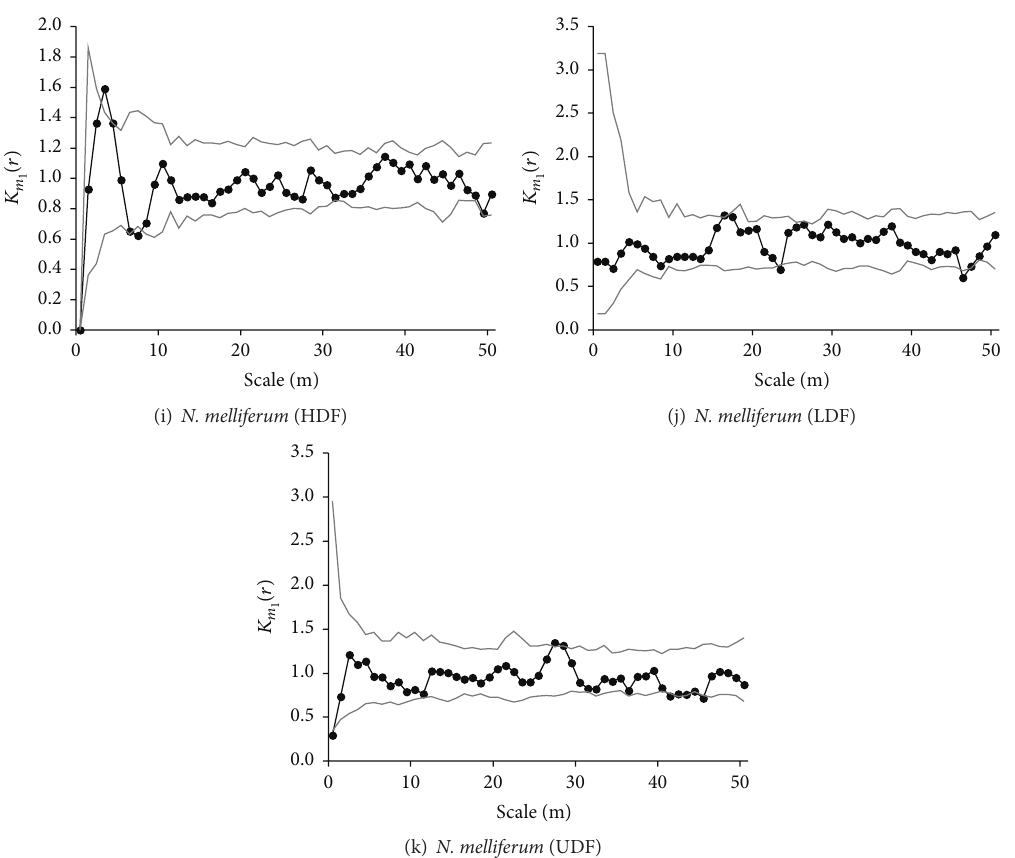
Figure 7: Spatial patterns of the five most abundant tree species shown by mark-correlation function with the null model of uncorrelated marks. Black lines are observed patterns and grey lines are approximate 95% confidence